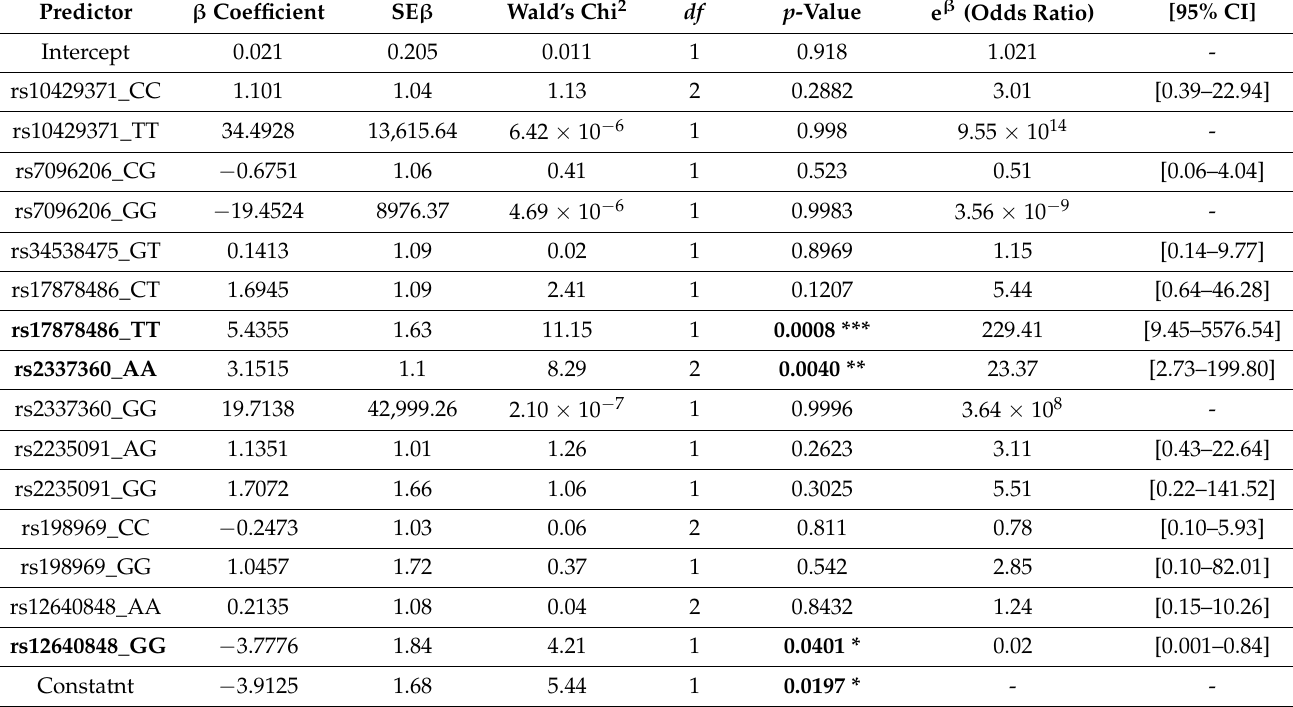
Table 8. The multivariable logistic regression analysis.